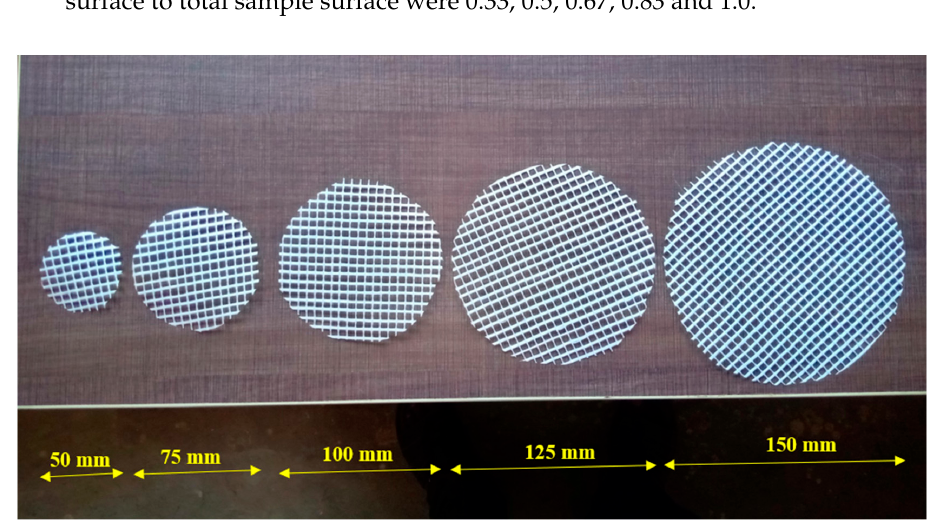
Figure 1. Hooked-end fiber.